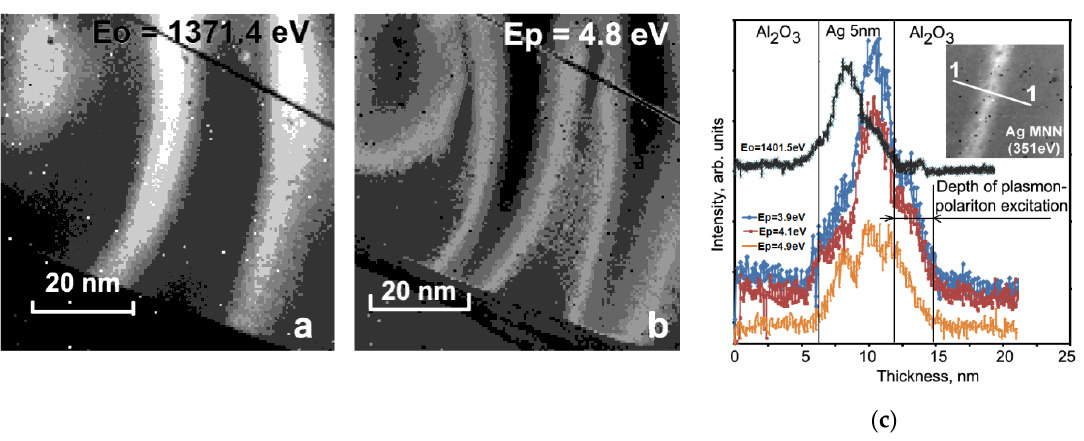
Figure 11. Scheme of physical conditions for plasmon-polariton excitation at the interface of Ag and Al 2 O 3 nanolayers. B—interface; VB—valence band; CV— conducting band; EF—Fermi level; LUMO—lowest unoccupied molecular orbital.